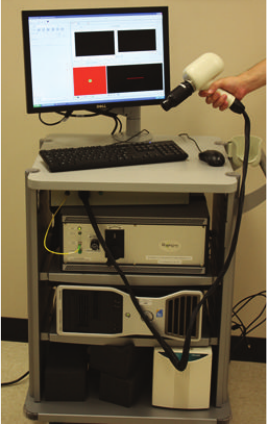
Figure 1: Anterior segment optical coherence tomography (ASOCT) system with handheld probe and cornea adaptation